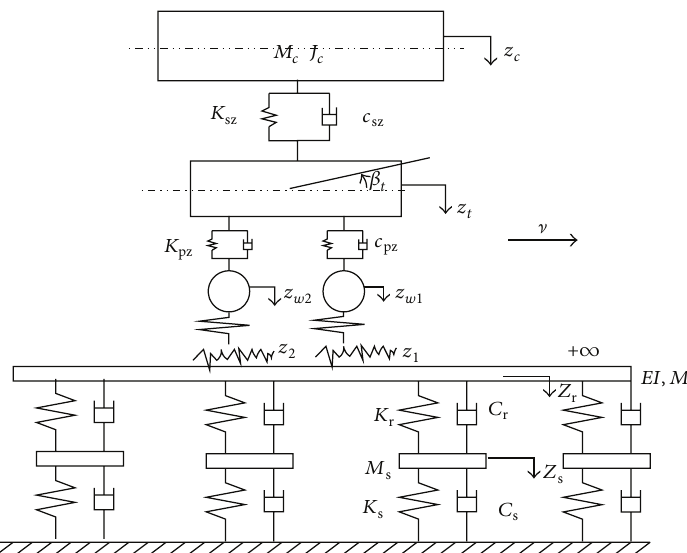
Figure 1: The vehicle-track coupled nonlinear